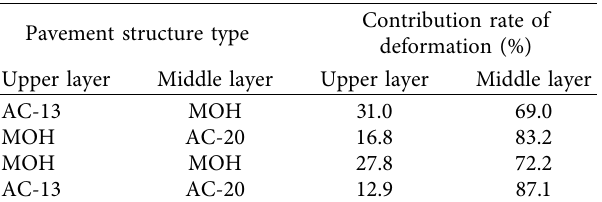
Figure S1: vertical strain at the top of the subgrade. Figure S2: vertical stress of the cross section. ( Supplementary Materials )